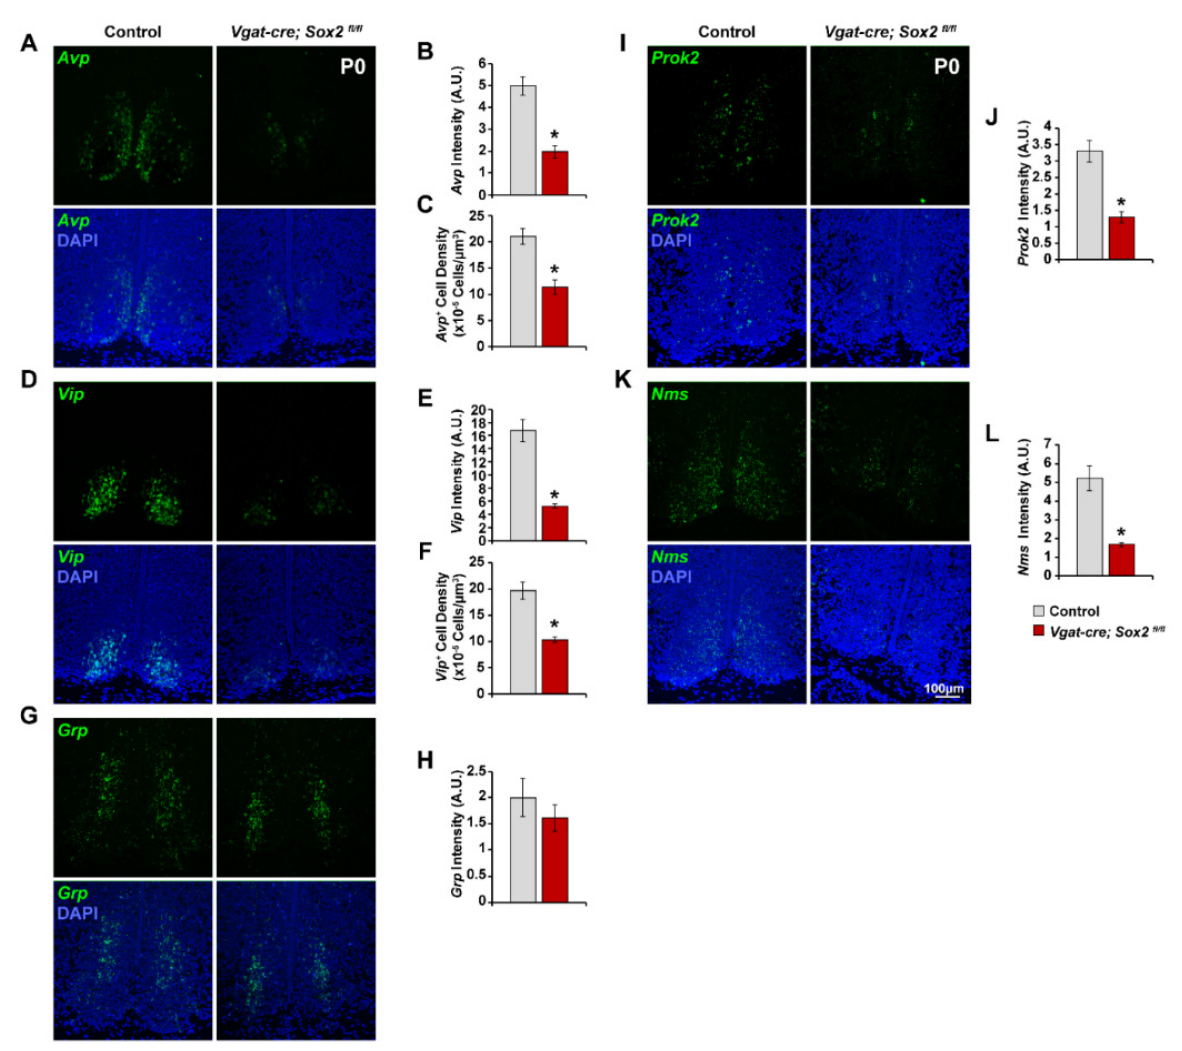
Figure 4. Effects of Sox2 ablation on neuropeptide expression in P0 SCN. ( A , D , G , I , K ) Representative photomicrographs of ( A ) Avp , ( D ) Vip , ( G ) Grp , ( I ) Prok2 , and ( K ) Nms expression (green) in the SCN of P0 control and Vgat-cre;Sox2 fl/fl mutant mice. Blue denotes DAPI. ( B , E , H , J , L ) Expression of ( B ) Avp , ( E ) Vip , ( H ) Grp , ( J ) Prok2 , and ( L ) Nms at P0 are quantified in arbitrary units of mean grayscale intensity in the whole SCN. ( C , F ) Quantification of ( C ) Avp + and ( F ) Vip + cell density in the P0 SCN. Values represent mean ± SEM. * p < 0.05 versus control mice, two-tailed Student’s t -test. See Table 2 for the number of animals and litters used.